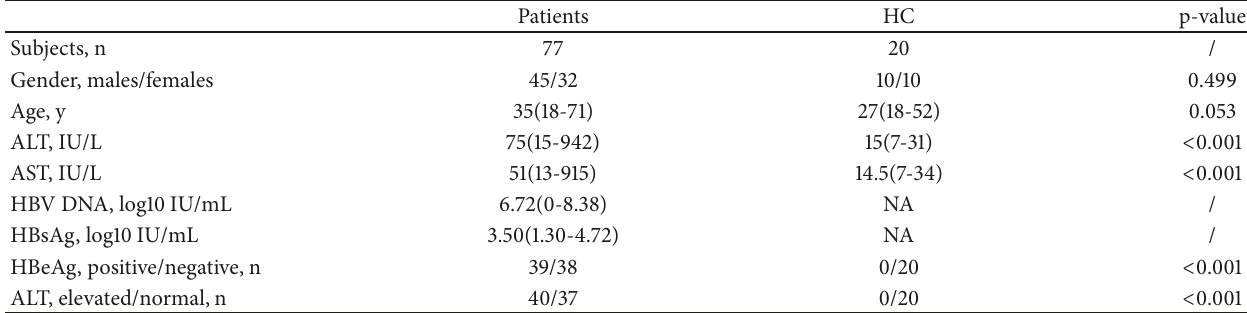
Table 1: Clinical characteristics of the patients with chronic HBV infection and healthy controls.